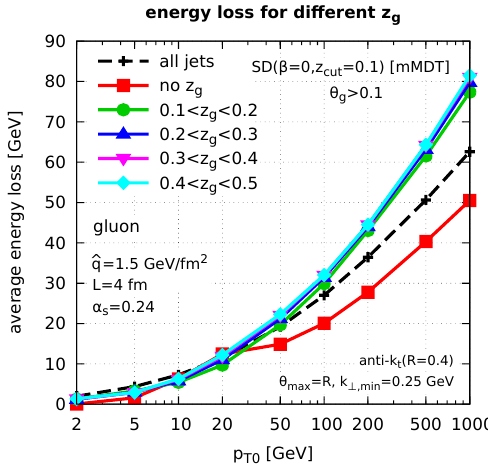
Figure 10 . Our MC results for the average energy loss by a gluon-initiated jet are displayed as a function of the initial gluon energy p T 0 in bins of z g . The inclusive (all jets) result is also shown, by the dashed